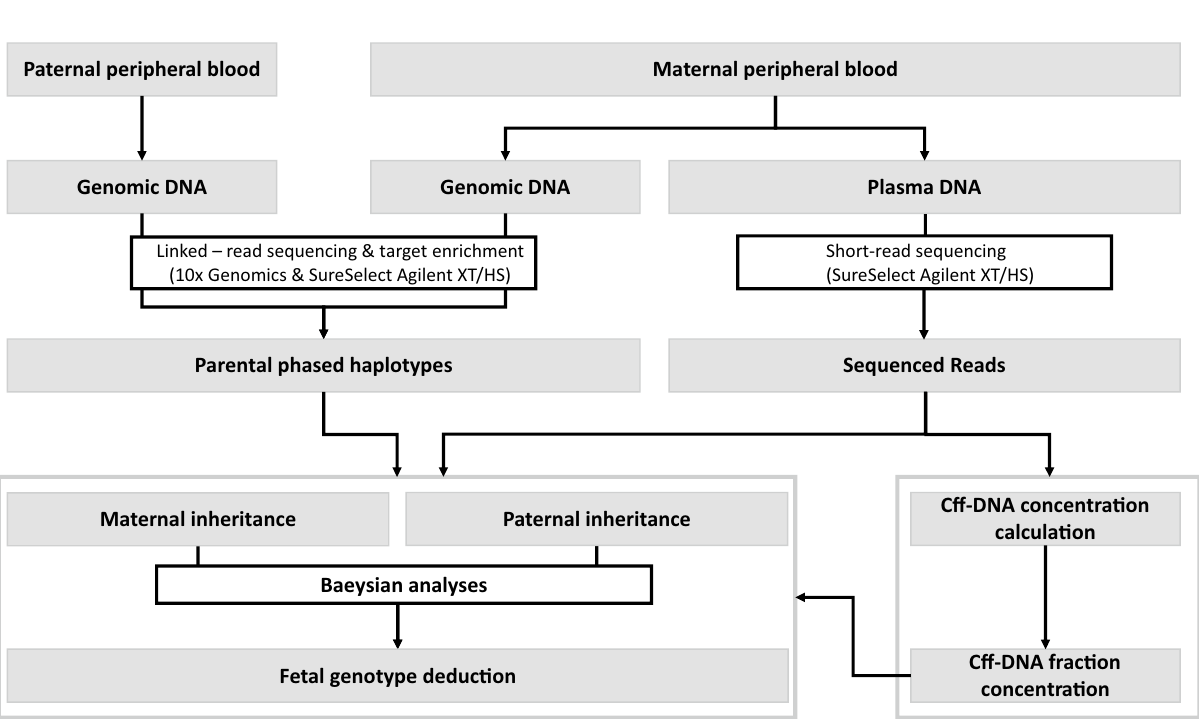
Figure 1. Flow chart of the overall strategy for noninvasive prenatal diagnosis of